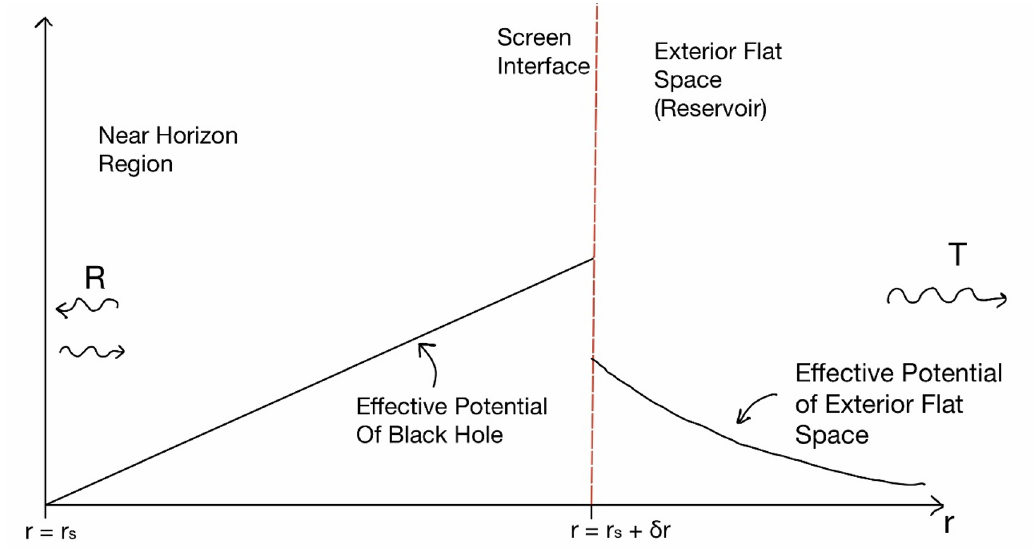
Figure 4 . Above is a depiction of the potential that we are considering to emulate an absorptive screen placed at r = r s + δr depicted by the dotted red line. We keep the effective potential the same as the black hole up until we get to the screen interface. We then transition to a potential for a flat space which will act as a reservoir for the extracted Hawking radiation. Close to the horizon the solution takes on the form of in-going and out-going plane waves. We normalize the outgoing wave near the horizon to unity and the amplitude of the in-going plane wave is R . The absorptive screen boundary condition is enforced by only allowing outgoing plane waves in the flat region with amplitude T . We patch the solutions and uniquely determine T and R by requiring continuity of the solution and its derivative at the screen interface. Then the generalized greybody factor is defined by | T | 2